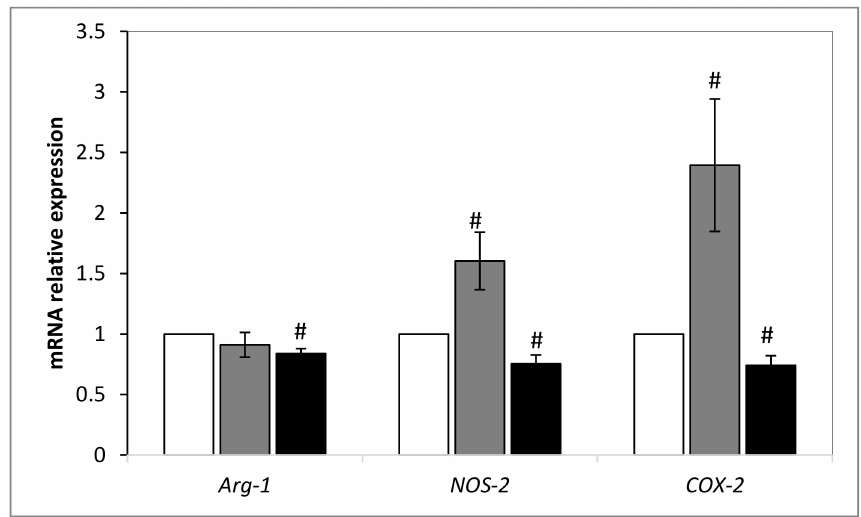
Figure 6. Relative expression level of Arg-1 , NOS-2 and COX-2 after DSC and DSS treatment by normalization against GAPDH gene. Results shown are mean values ± standard error of the mean where ( # p < 0.05) indicates a significant di ff erence between gene expressions among mice treated with PBS and those extract-treated, according to the one-way ANOVA test followed by Tukey test using Origin 8. White: Non-treated mice; grey: DSS treated mice; black: DSC treated